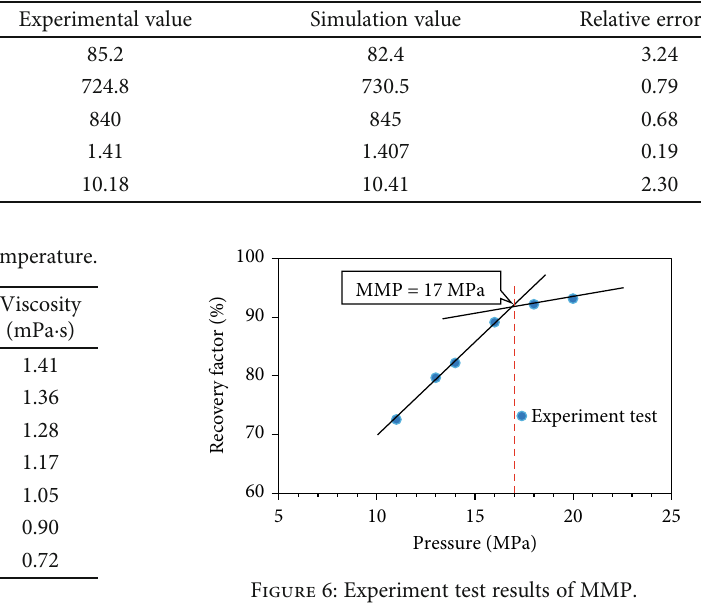
Table 8: Test results of MMP.